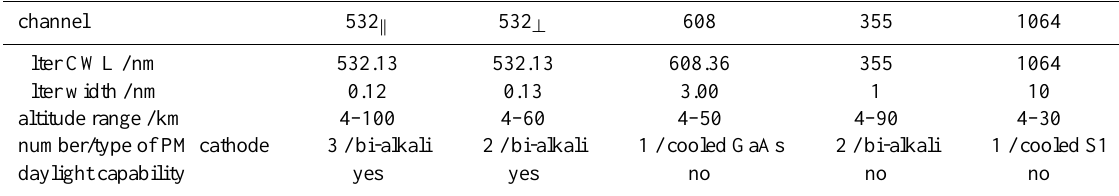
Table 5. Characteristics of the receiver branches.